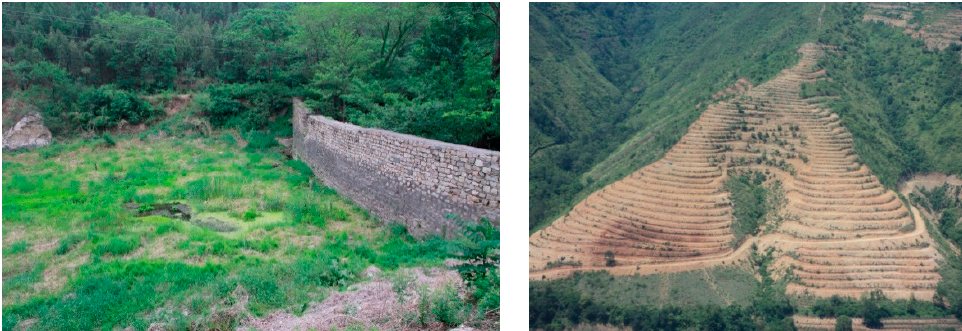
Figure 7. Soil-retaining dam and slopes reshaped into terraces in the Haihe River Basin.